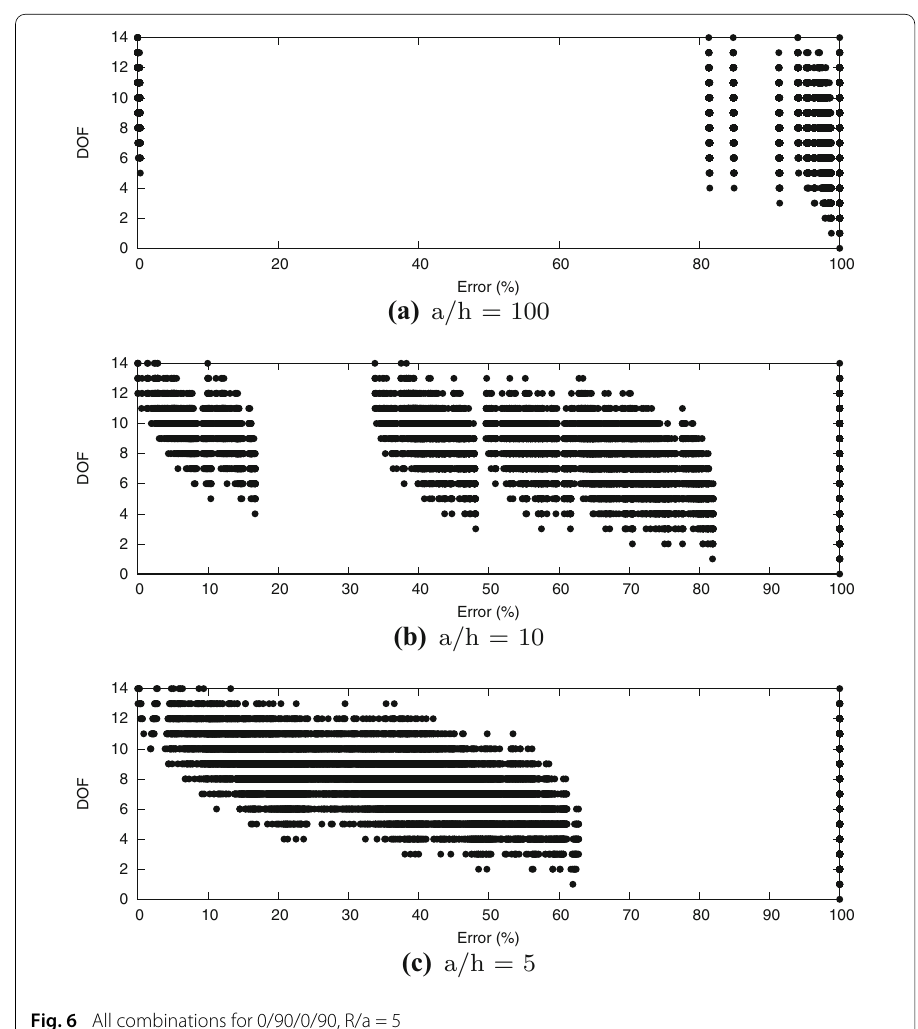
Fig. 6 All combinations for 0/90/0/90, R/a =